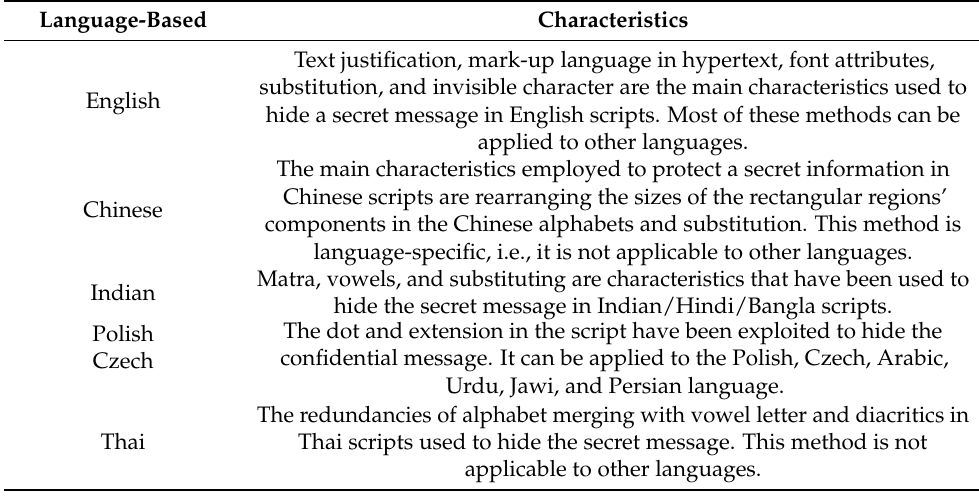
Table 6. Fundamental characteristics of format-based text